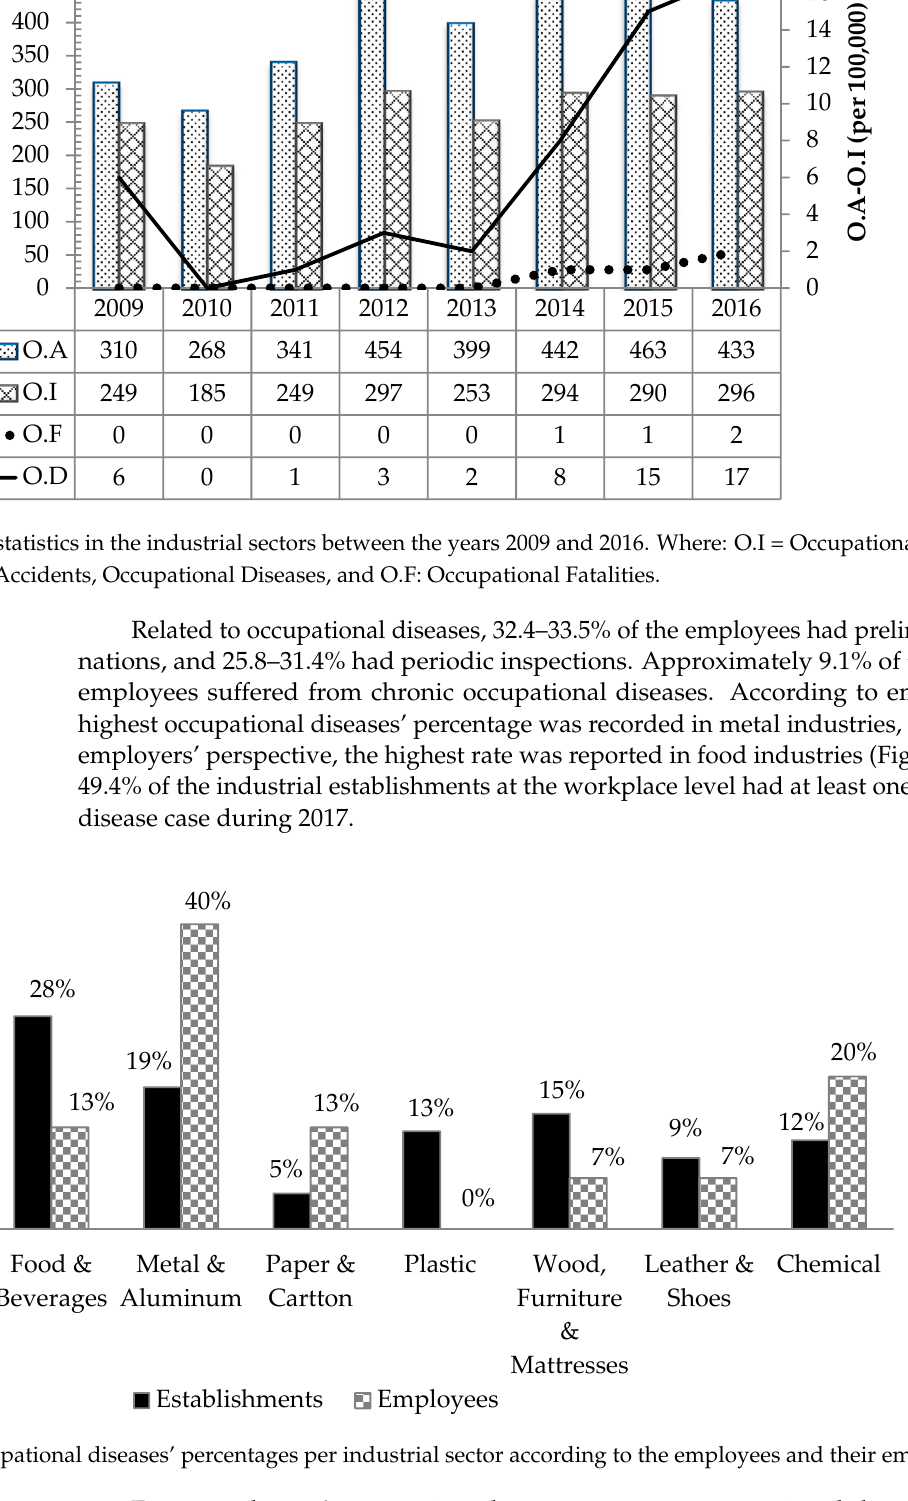
Figure 7. The occupational diseases’ percentages per industrial sector according to the employees and their employers.